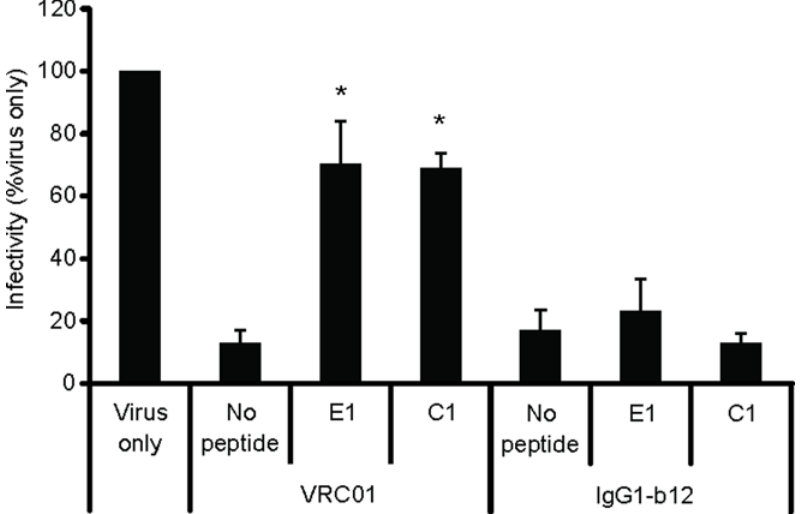
Fig 4. The E1 and C1 peptides specifically relieve neutralization by VRC01. The luciferase activity from virus-only infection was set to 100%. The luciferase activity produced by virus with the addition of VRC01 (IC90 = 6.26 μ g/ml) or IgG b12 (IC90 = 12.5 μ g/ml) without peptides was used to determine rescue of neutralization. Asterisk indicates statistical significance from the virus/VRC01 or virus/IgG1 b12 controls (p (cid:1)